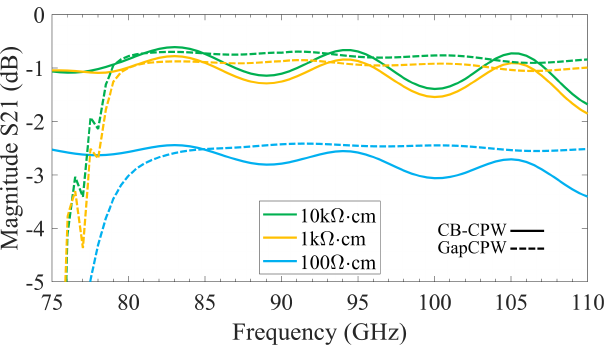
Figure 19. W–band Simulated S 21 Parameters in HFSS for 5-mm-long lines with varying